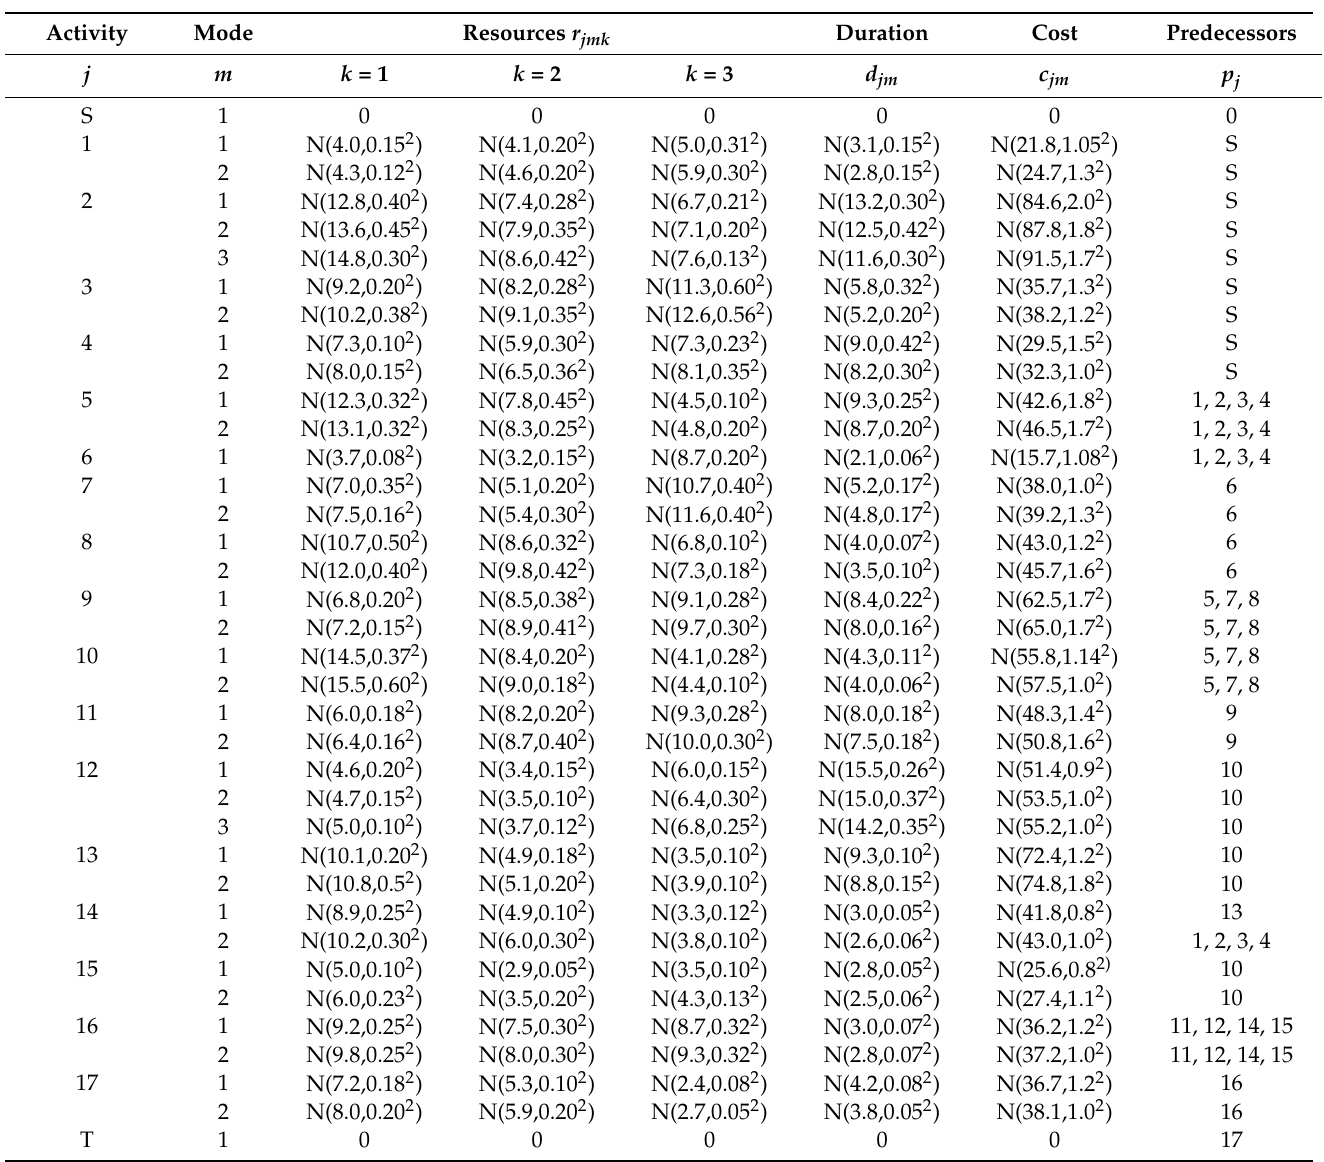
Table 4. Concrete double-curvature arch dam project activity